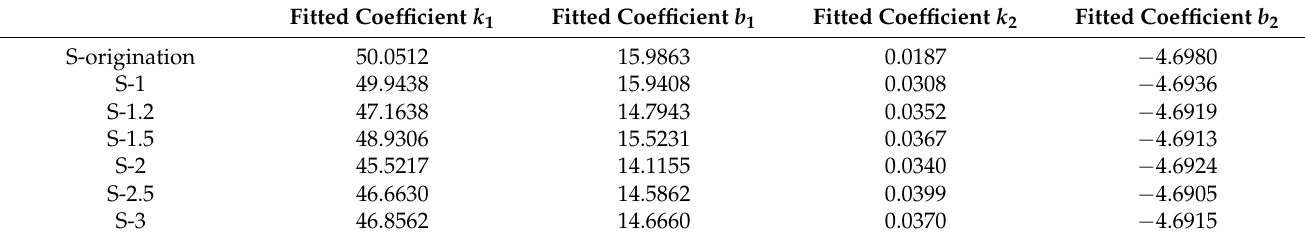
Table 6. Comparison of data points of